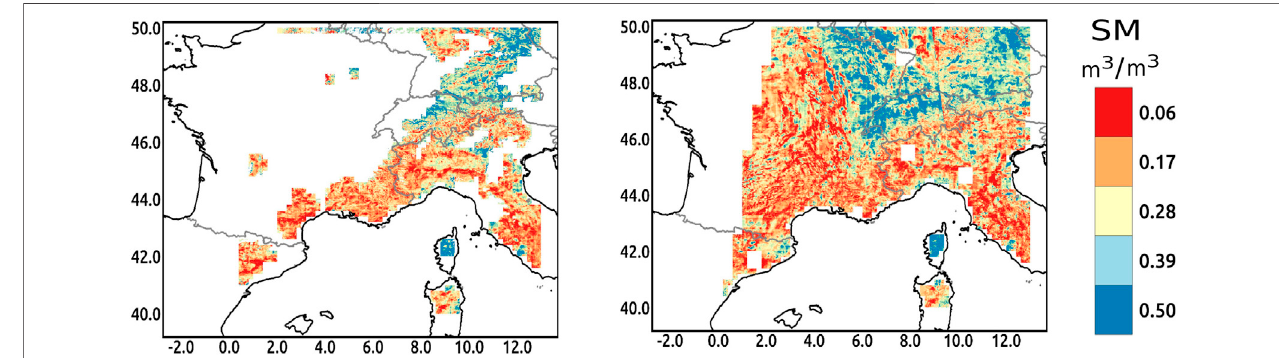
FIGURE 5 | DISPATCH veg – ext 1 km resolution SM images for MODIS (left) and Sentinel-3 (right) LST input data on DOY 204, 2018.